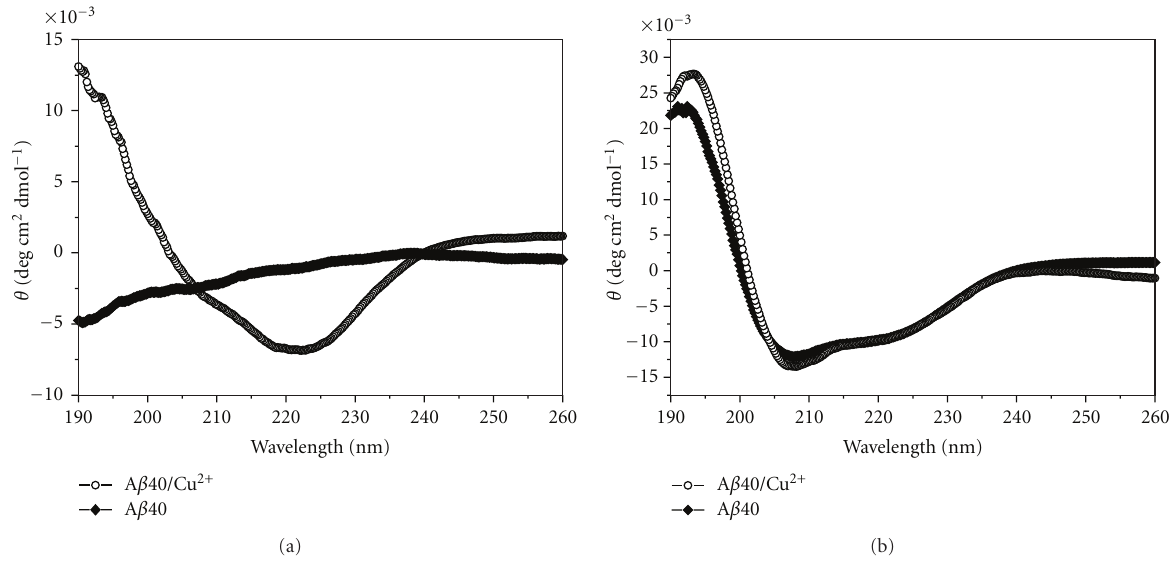
Figure 1: Circular dichroism spectra of A β 40 peptide with or without Cu 2+ in (a) 5% TFE and (b) 40% TFE. The concentration for both A β 40 and Cu 2+ used in measurements was 10 μ M. It can be seen that the conformation of A β 40 in 5% TFE shows a dramatic change in the presence of Cu 2+ , while the conformation of A β 40 in 40% TFE remains unchanged in the presence or absence of Cu 2+ .